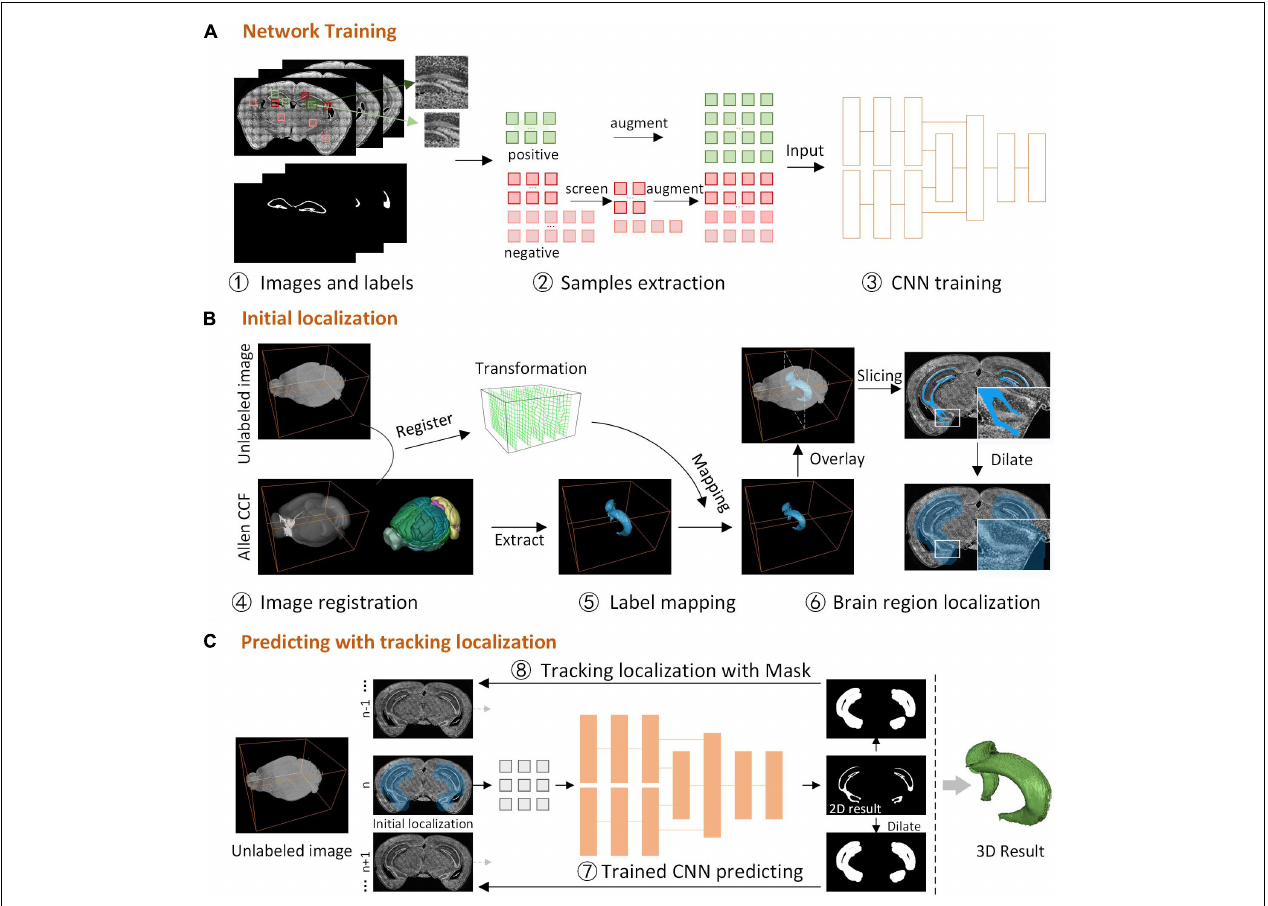
FIGURE 1 | The framework for DeepBrainSeg. (A) Network training, the acquisition of images and labels, samples extraction, building and training the CNN. (B) Initial localization, image registration for the unlabeled image and Allen CCF, mapping the label to the image, and initial localization the brain region. (C) Predicting with tracking localization, predicting the initial image, dilating the 2D result as the localization of adjacent images, alternating prediction and localization to obtain a 3D result.